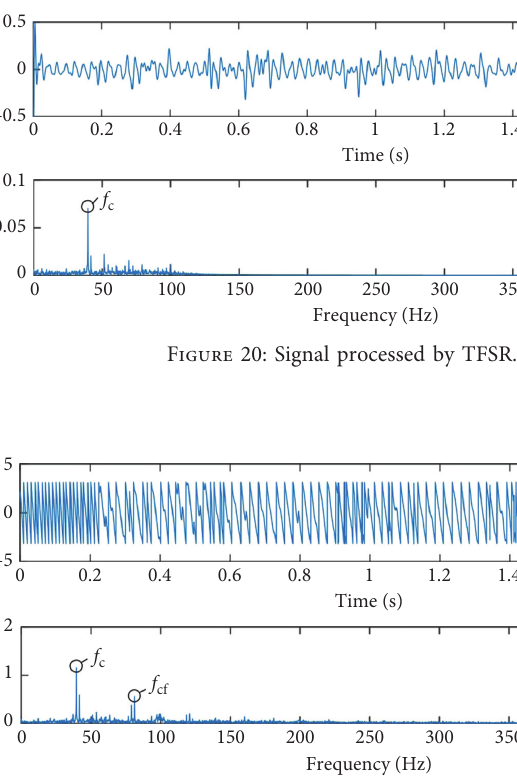
Figure 21: Signal processed by